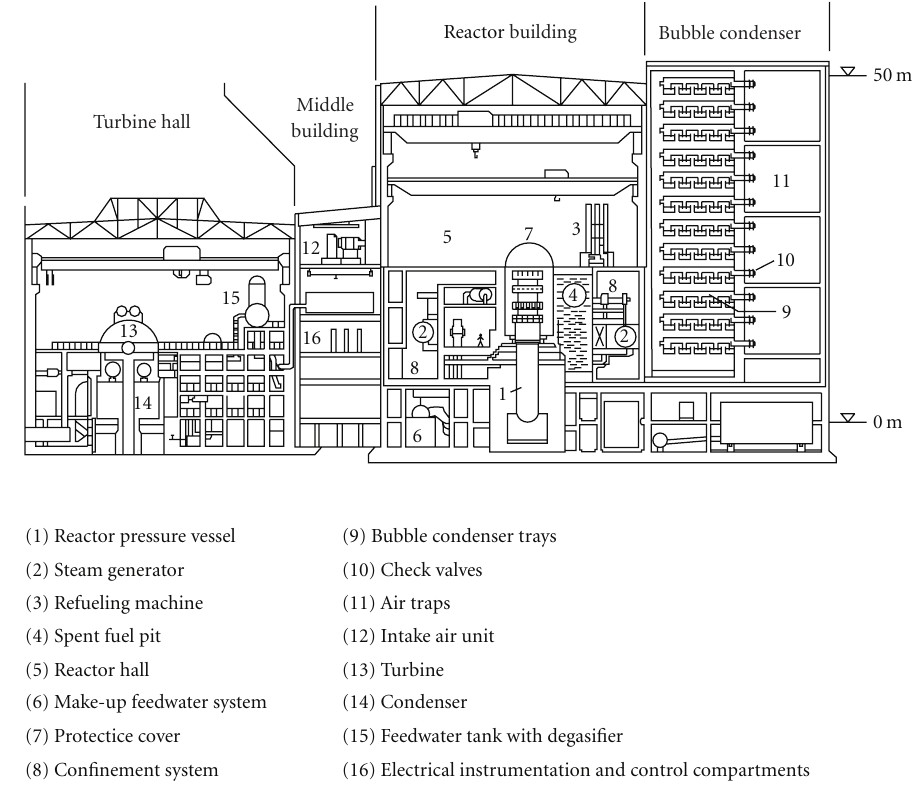
Figure 1: VVER-440/213 plant